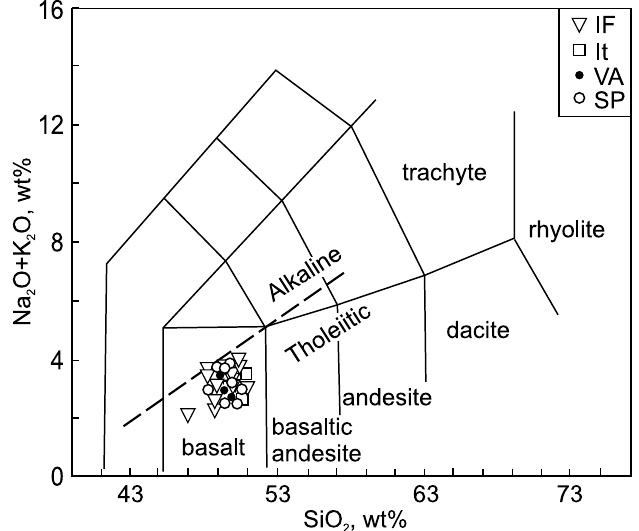
Fig. 5 – Total alkalis-silica (TAS) diagram (Le Bas et al. 1986) showing the geo- chemical characteristics of rocks from the Vista Alegre region. The bold, dashed line distinguishes tholeiitic from alkaline basalts (MacDonald and Katsura 1964).